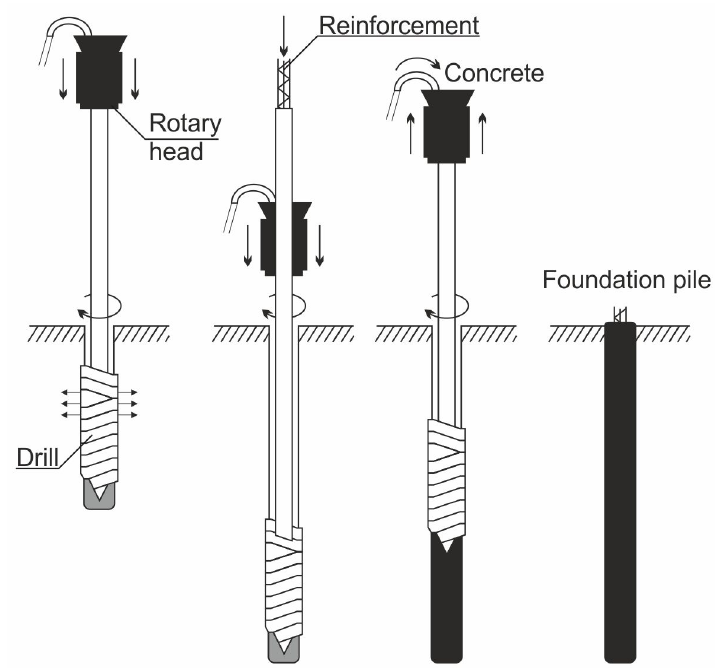
Figure 2. Diagram for execution of a displacement pile based on [63].